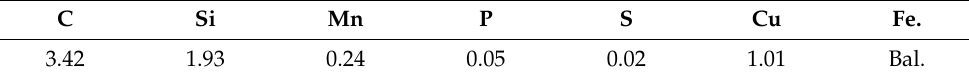
Table 1. Chemical composition of the ductile iron in the study (wt.%).